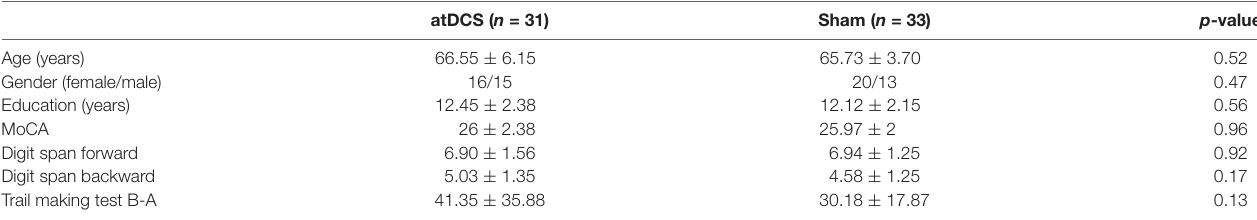
TABLE 1 | Demographic characteristics and neuropsychological results (mean ± standard